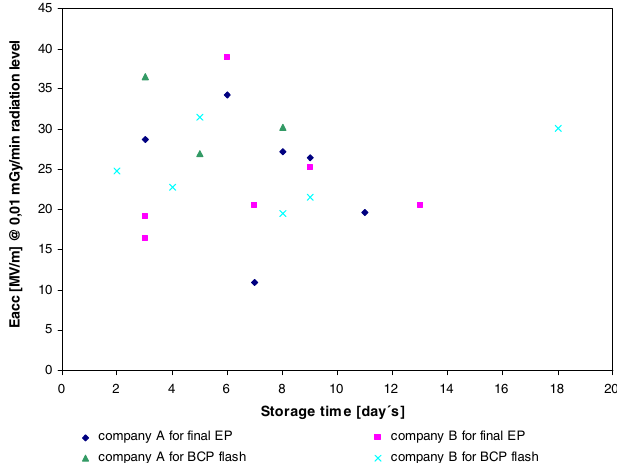
FIG. 3. (Color) Correlation of storage time of cavities in ultra- pure water and acceptance gradient at first rf test.